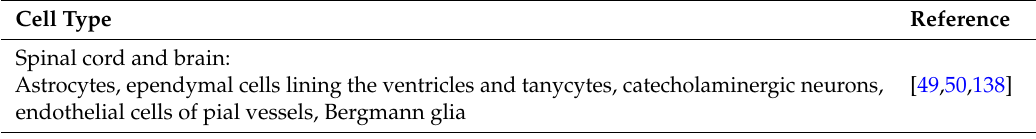
Table 5. The expression of AQP9 in different cell